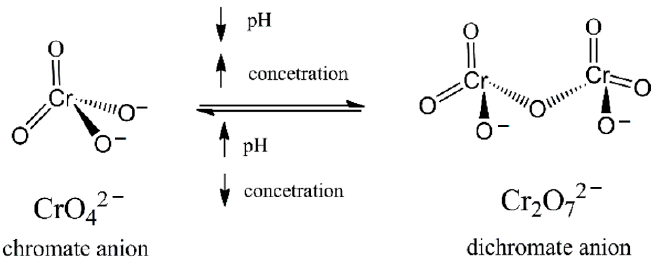
Figure 2. Structures of tetrahedral chromate, and dichromate (modified from ref [27]).